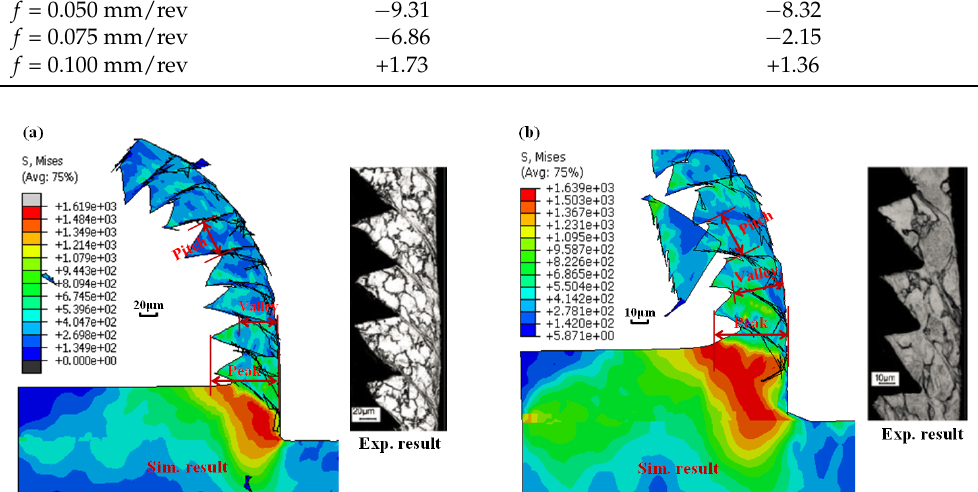
Figure 4. Comparison of the simulated (Sim.) and experimental (Exp.) chip morphologies in Ti-phase cutting modeling [36]: ( a ) test condition 1 ( v c = 1200 m/min and f = 70 μ m/rev); ( b ) test condition 2 ( v c = 4800 m/min and f = 35 μ m/rev) (Note: the symbol “S” in the figure represents the von Mises stress and the unit is MPa). Table 7. Comparison between simulated (Sim.) and experimental (Exp.) chip geometries in Figure 4. Sim./Exp.